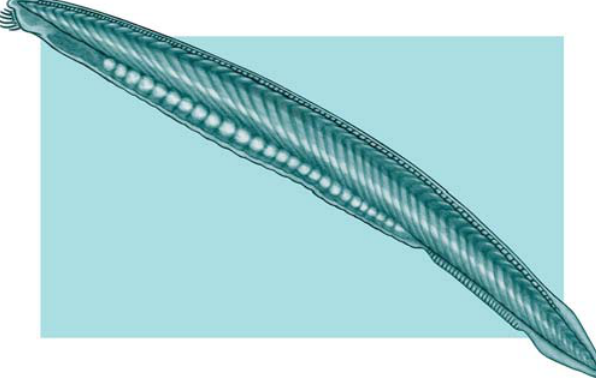
Figure 1. Amphioxus, a Small, Translucent, Fish-Like Animal That Is the Closest Living Invertebrate Relative of the